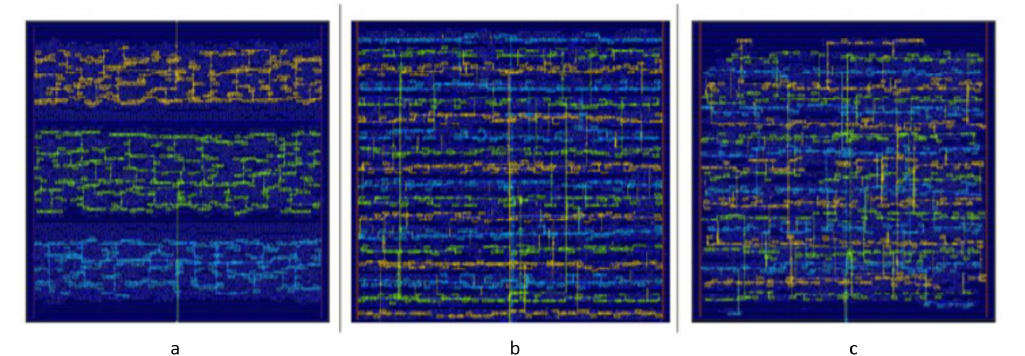
Figure 8. Clock tree coloured for the three branches A, B and C: ( a ) Clocktree 3Blocks method ( b ) Clocktree interleaved method ( c ) Clocktree interleaved 2.0 method.